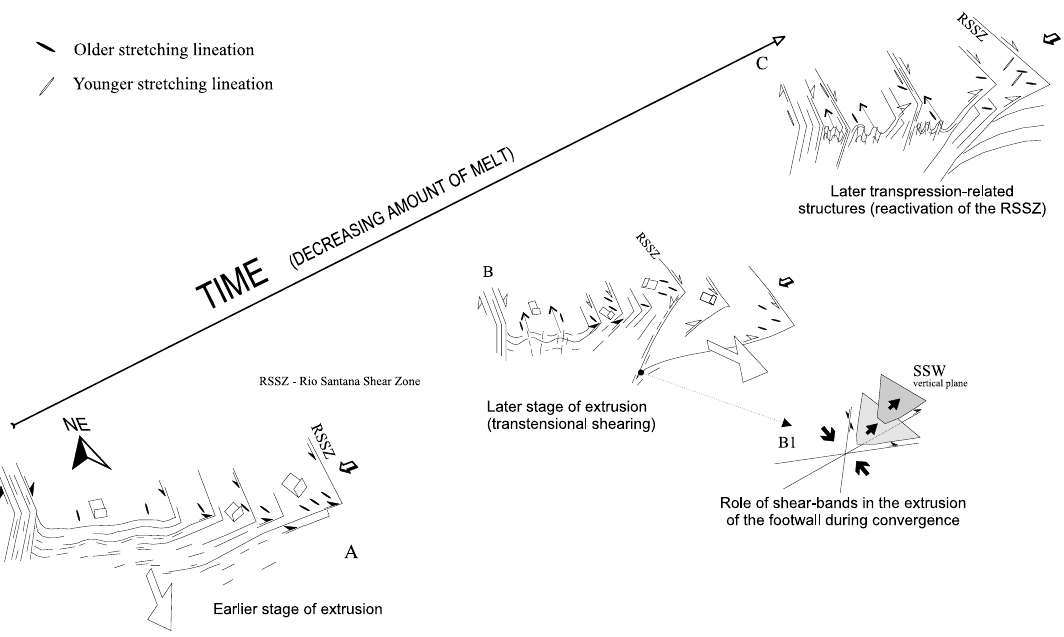
Fig. 5 – Cartoon showing the tectonic model for the southern limb of the structural divergent fan, and the extensional motion in the RSSZ: (a) Initial kinematic stage with high-temperature, transient melt-assisted SSW-directed motion (earlier extrusion stage); (b) Transtensional shearing nucleated in order to maintain strain compatibilities between obliquely moving, heterogeneously deforming and partially molten crustal slices (later extrusion stage). A sketch showing the interpreted role of the late shear bands on the extrusion of the footwall is also shown (b 1 ) ; (c) Thrusts, folds and ductile dextral shear zones resulting from progressive increase of finite transpressional strain (after N.M. Dehler, unpublished data). See text for further